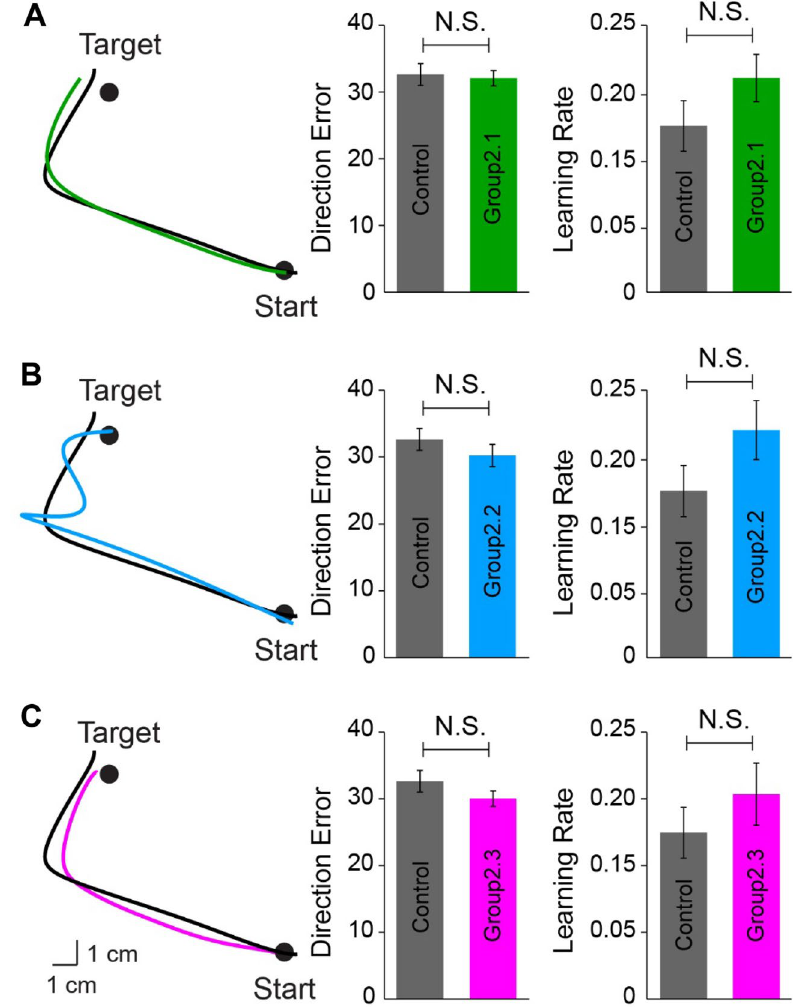
Figure 4. Hand-paths from representative subjects observed on the first trials during the transfer session were compared between the experimental groups (color) and the control (black) in the left panels for 2.1, 2.2, and 2.3, respectively ( A-C , left). Mean errors of the first trial were plotted (mean ± standard error) in the mid panels ( A-C , middle), and the learning rates were plotted on the right panels ( A-C , right). N.S. indicates not significant ( p >